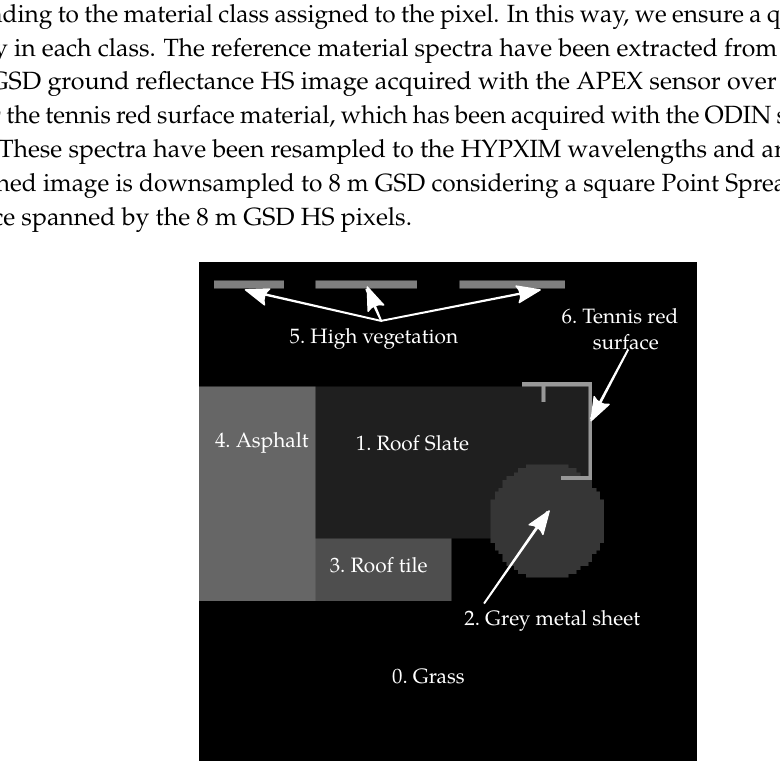
Figure 3. Class image at 2 m Ground Sampling Distance (GSD) with seven distinct materials. The area spanned by the high vegetation is 4 m wide. The tennis red surface is 2 m wide. At the hyperspectral (HS) image resolution, those two materials are present only in mixed